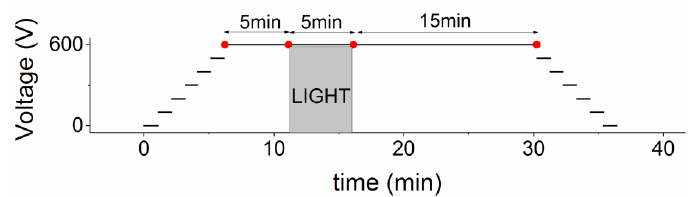
Figure 2. The voltage and light excitation sequence of the experiment. Results corresponding to red points are shown in Figure 3.